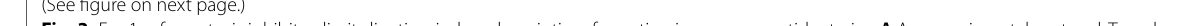
Fig. 3 Fer‑1, a ferroptosis inhibitor, limits ligation‑induced neointima formation in mouse carotid arteries. A An experimental protocol. Two days after ligation, C57BL/6J mice were intraperitoneally injected with vehicle or Fer‑1 (1 mg/kg/day) for 28 days. Then, the carotid arteries were collected for further analysis. B Perl’s Prussian blue staining in mouse carotid artery (neointima outlined by black dashed line). The number of iron + cells in neointima per field ( n 5, vehicle and n 6, Fer‑1). Scale bar, 100 μm. C Immunofluorescent staining of COX‑2 in mouse carotid artery (neointima = = outlined by white dashed line). Quantification of COX‑2 MFI ( n 5, vehicle and n 6, Fer‑1). Scale bar, 50 μm. D H&E staining of ligated carotid = = arteries from C57BL/6J mice treated with Fer‑1 or vehicle (neointima outlined by black dashed line). The intima/media ratio was calculated ( n 5, = vehicle and n 6, Fer‑1). Scale bar, 100 μm. E Immunofluorescent staining of α‑SMA in mouse carotid artery (neointima outlined by white dashed = line). Quantification of α‑SMA MFI ( n 5, vehicle and n 6, Fer‑1). Scale bar, 50 μm. Data are presented as mean SEM, P values calculated by a = = ± two‑tailed unpaired Student’s t ‑test. * P < 0.05, ** P < 0.01, *** P